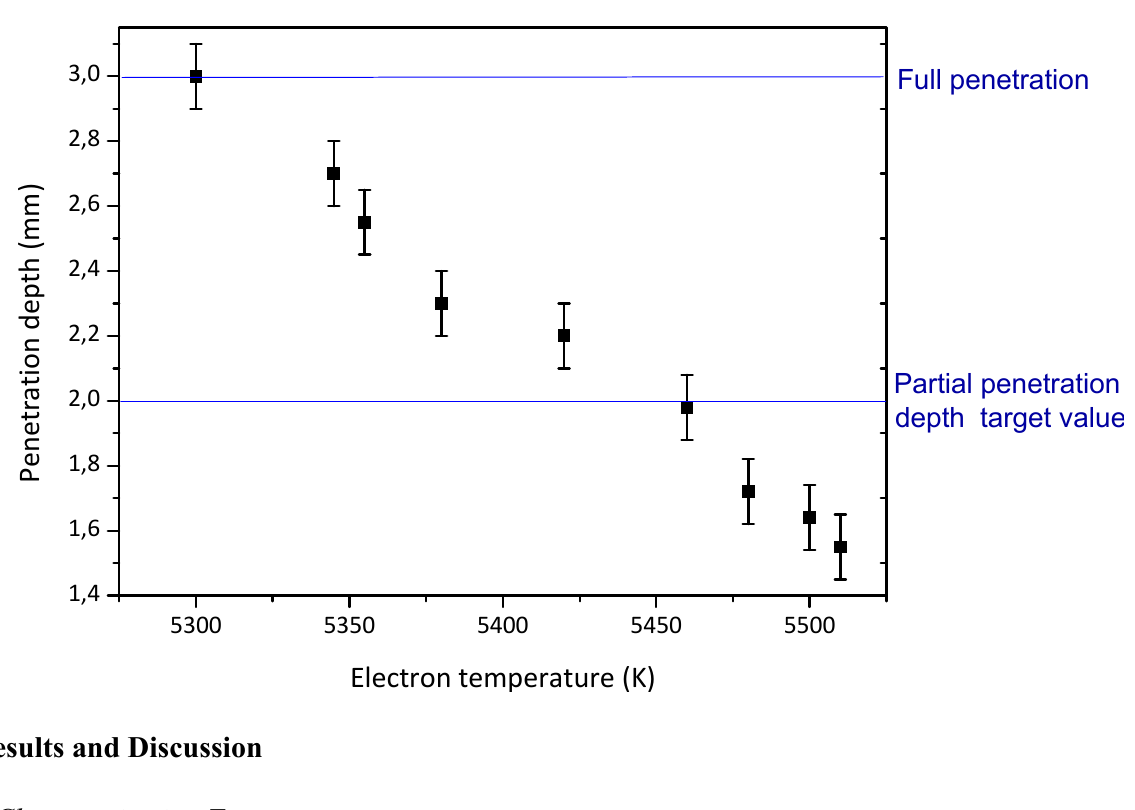
Figure 3. Characterization curve of penetration depth as a function of the Fe(I) electron temperature, at a welding speed of 50